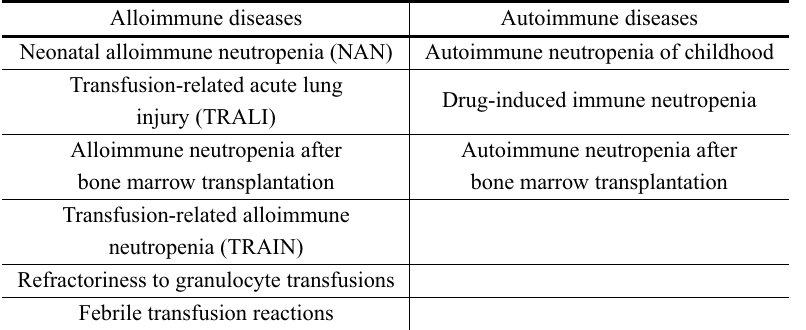
Clinical conditions associated with neutrophil antibodies.